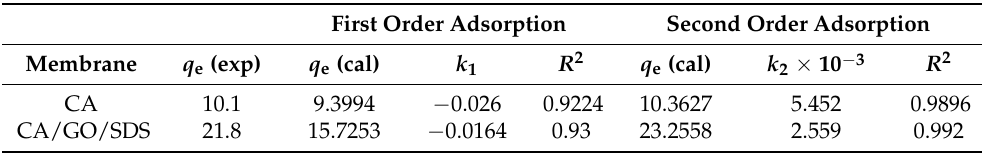
Figure 6. The adsorption kinetics of phosphate adsorption by the CA and the CA/GO/SDS for the pseudo-second-order model. Table 1. Comparison between the experimental and calculated q e values for different membranes in the first- and second-order adsorption isotherms at a phosphate concentration of 25 mg L − 1 .